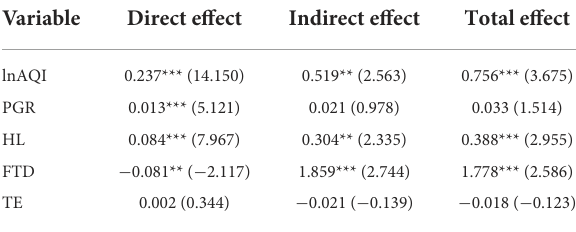
TABLE 4 Decomposition